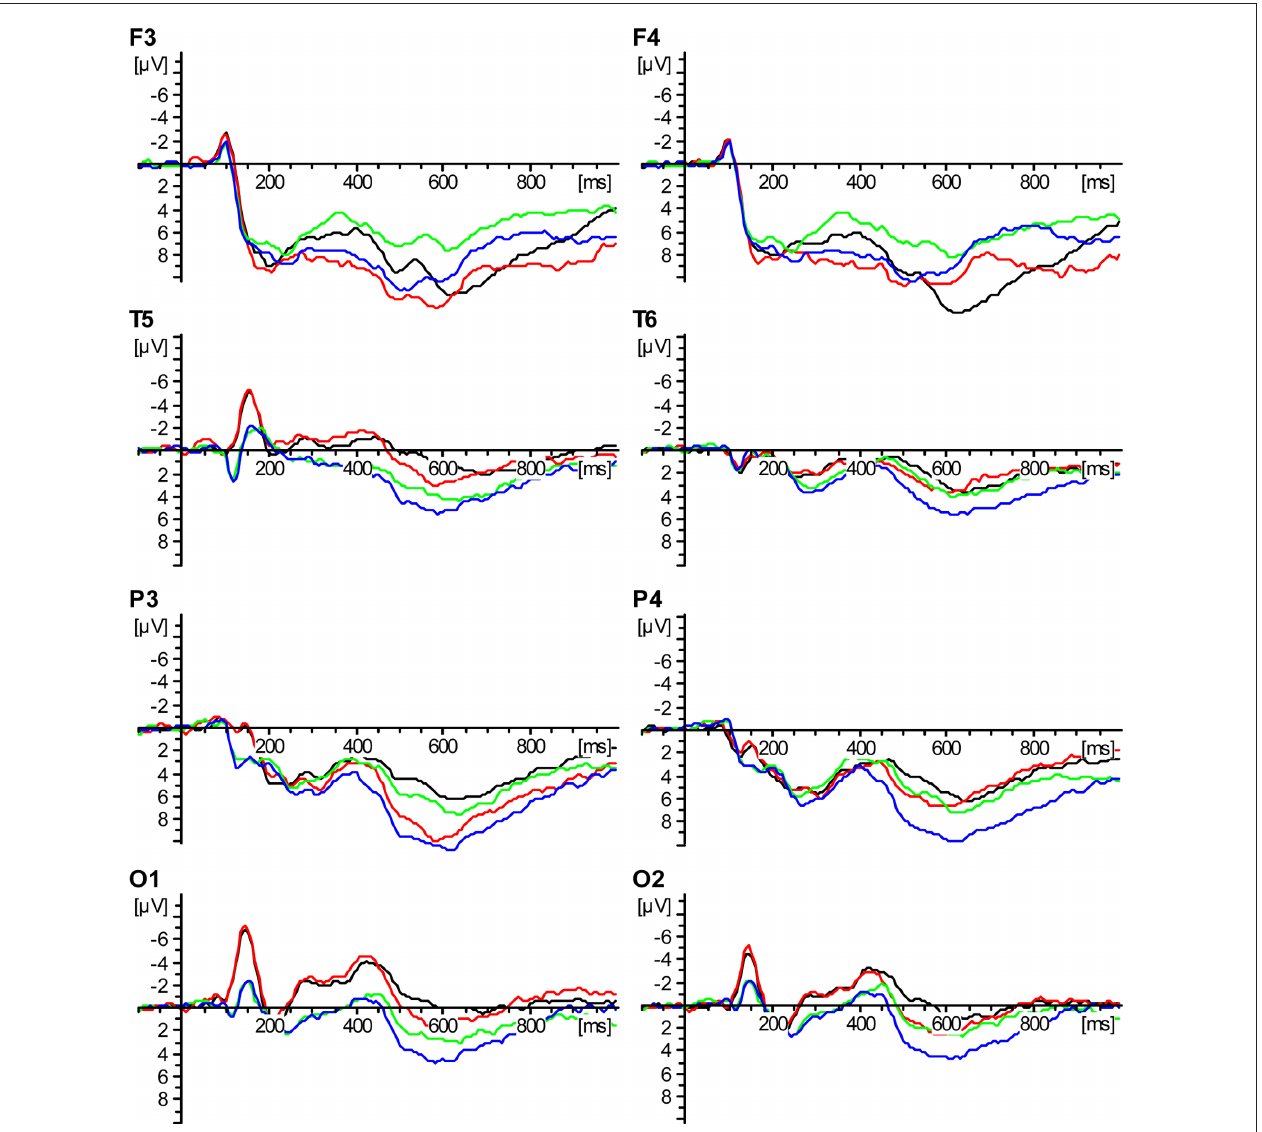
FiguRe 1 | event-related potential-data. ADHD patients: first presentation – black; ADHD patients: second presentation – red; control group: first presentation – green; control group: second presentation